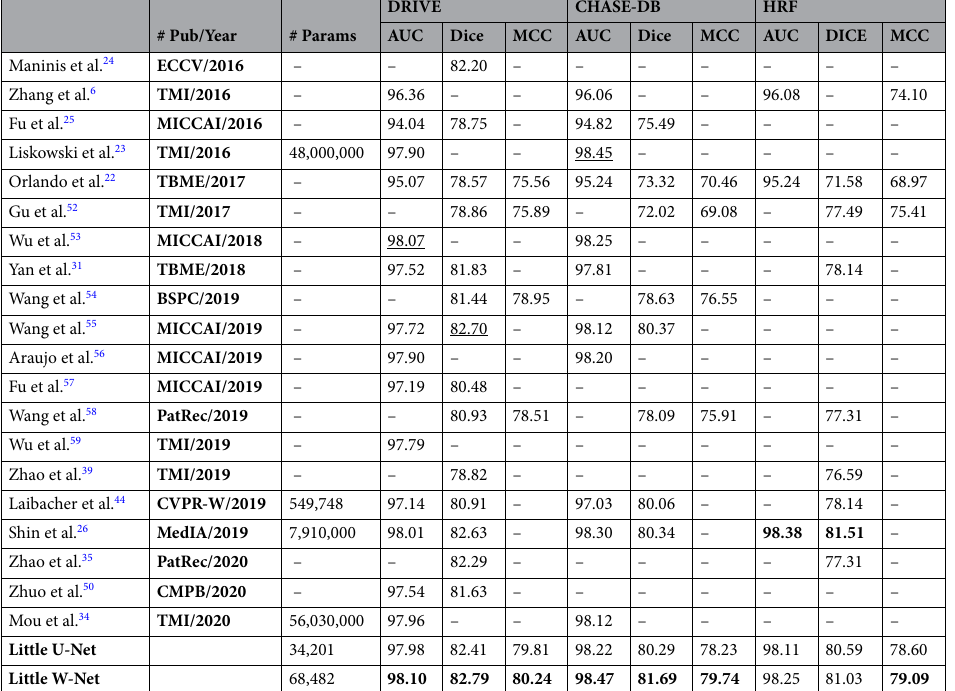
Table 2. Performance comparison of methods trained/tested on DRIVE, CHASE-DB, and HRF. Best results are marked bold. A result is underlined whenever it lies within the confidence interval of the Little W-Net model (specified in Table 3 below).